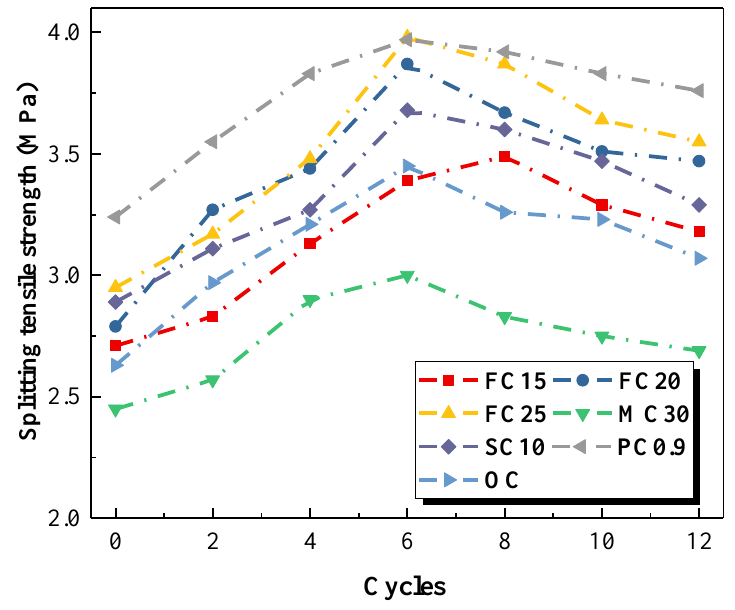
Figure 4. Splitting tensile strength variation.